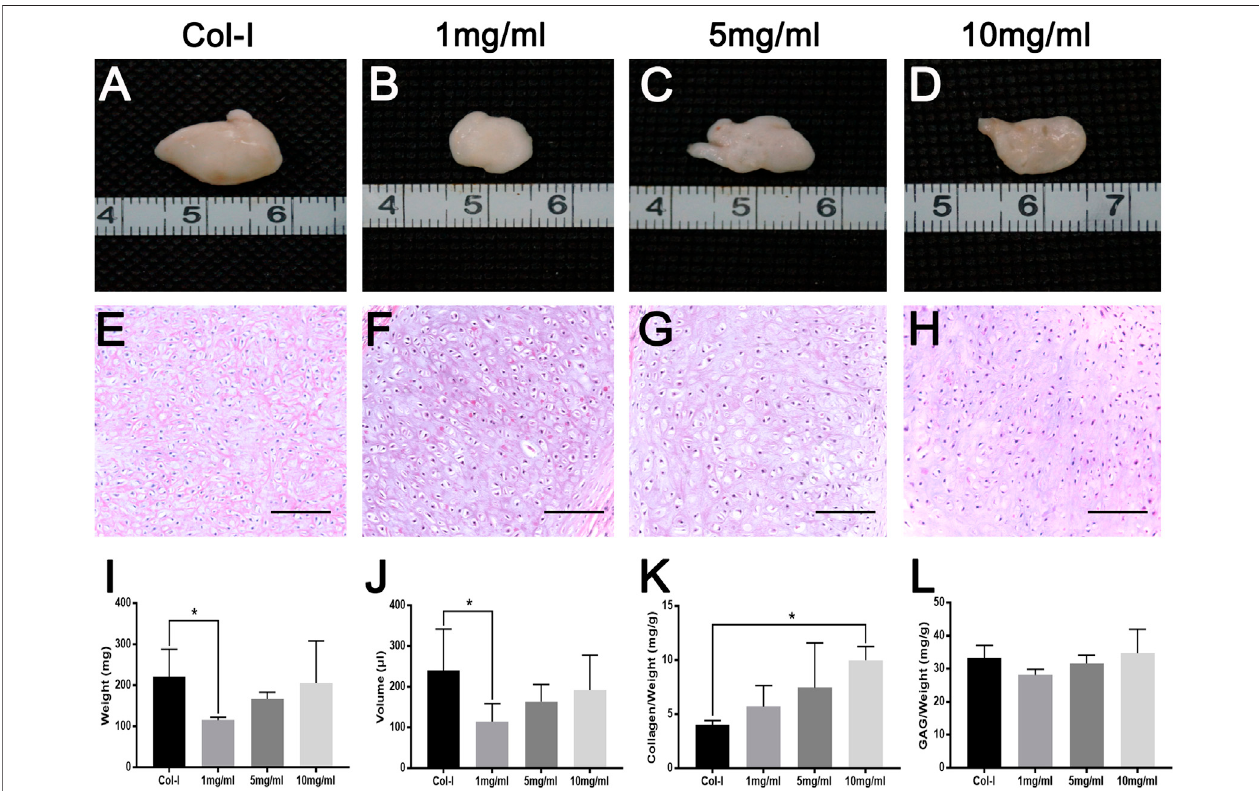
FIGURE 7 | Macroscopic appearance, HE staining and gross measurements of dcECM hydrogel grafts after 8 weeks of in vivo transplantation. Grafts were harvested and compared at 8 weeks after transplantation. (A – H) Macroscopic appearance and HE staining of collagen I (Col-I) (A, E) and dcECM hydrogels at 1 (B, F) , 5 (C, G) , and 10 (D, H) mg/ml grafts. (I, J) Gross analyses of weights (I) and volumes (J) from grafts. (K, L) Comparisons of collagen and GAG contents of grafts after 8 weeks of in vivo culture. Scale bars (cid:2) 100 µm. Error bars showed means ± SD, * p < 0.05, n (cid:2)